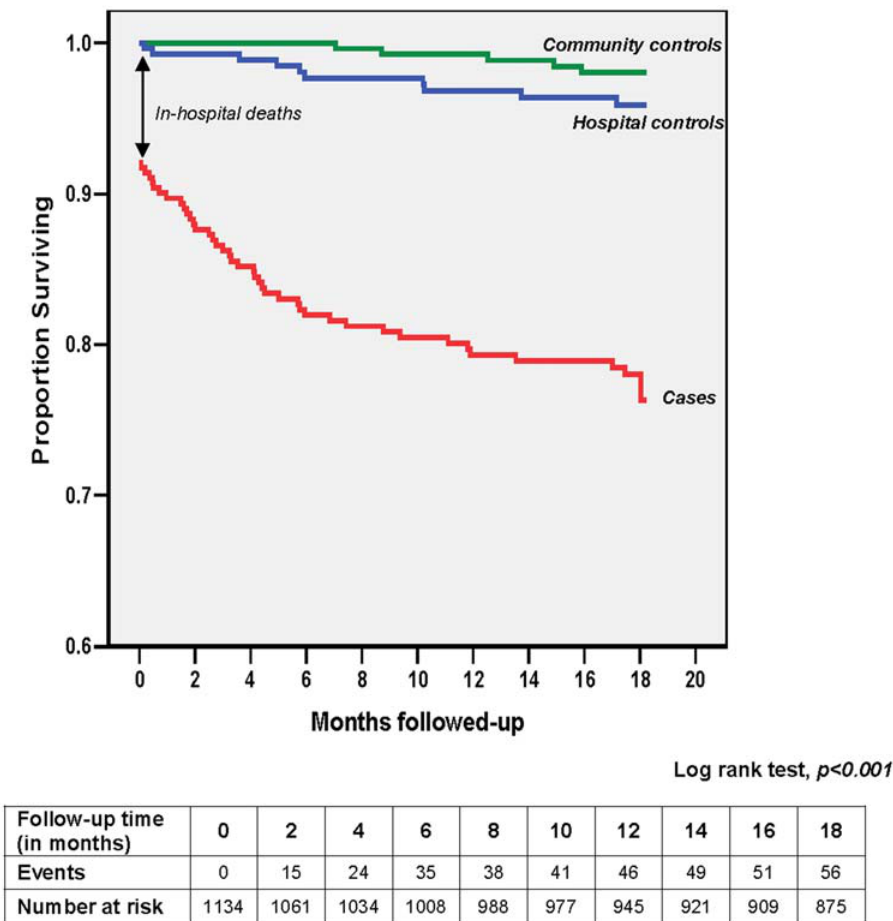
Figure 1. Survival curve showing the time to post-discharge death and the events versus number at risk of severely anaemic children ( cases ) and hospital and community controls during the follow-up period.